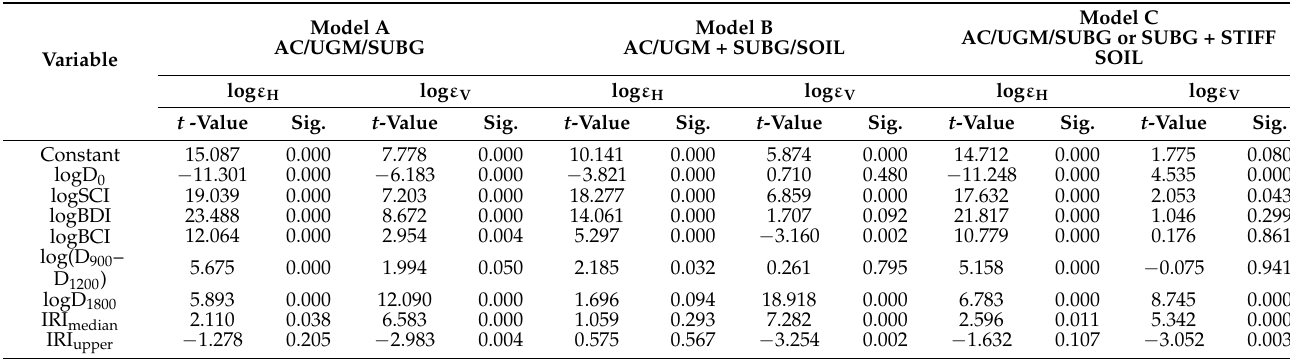
Table 9. Synopsis of stepwise regression analysis for all pavement